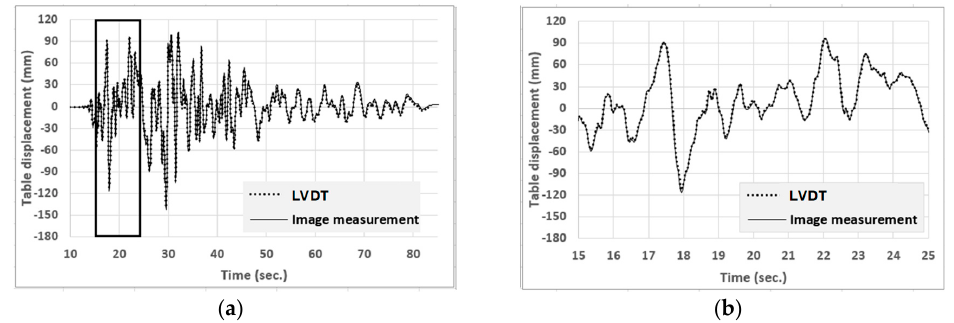
Figure 23. Table displacement histories from the LVDT and image analysis. Image measurement of table movement matches those of the LVDT. ( a ) Overall view ( b ) Magnification between 15 s and 25 s.